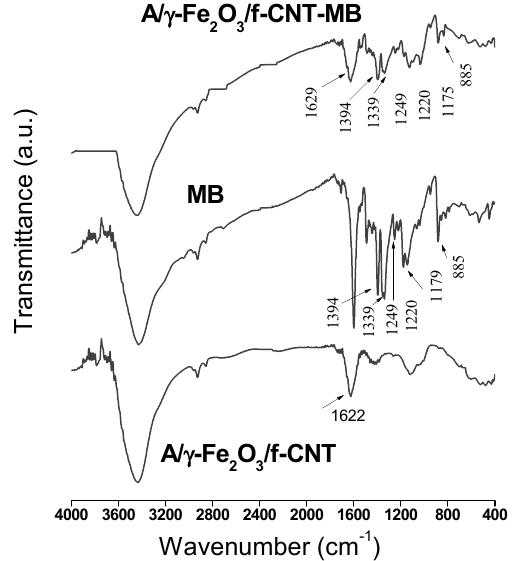
Figure 9. FTIR spectra of MB and A / γ -Fe 2 O 3 / f-CNT beads before and after MB adsorption.